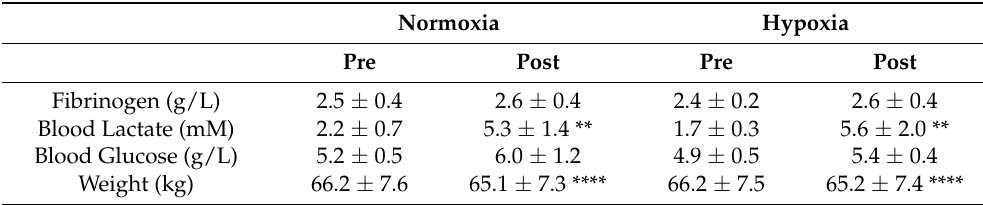
Table 2. SpO 2 , fibrinogen, blood lactate and glucose concentration, and